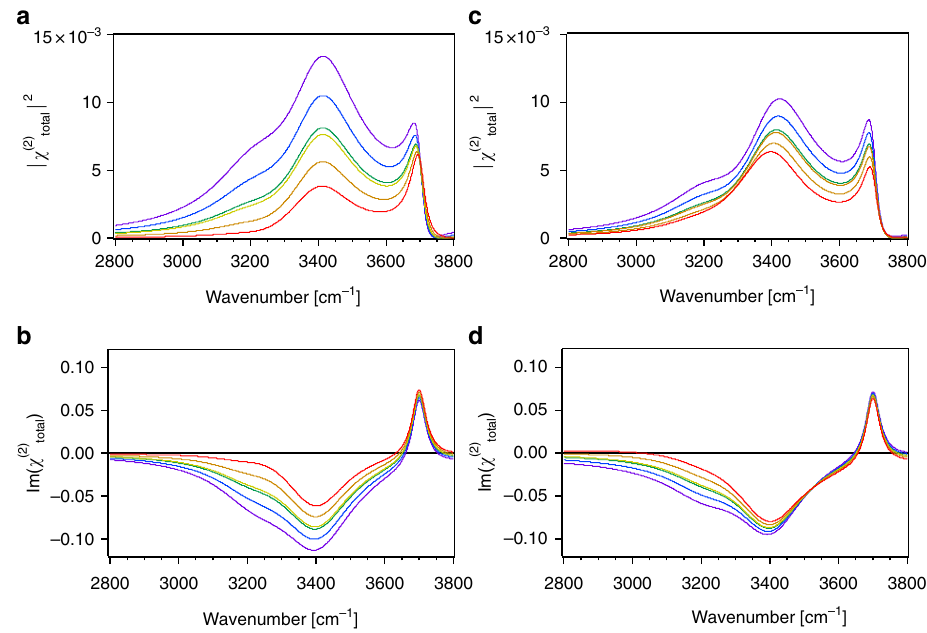
Fig. 5 Air/water interface. Intensity and imaginary SFG spectra for three oscillators on a surface simulated for ω 1 = 3200 cm − 1 , γ 1 = 0°, ω 2 = 3400 cm − 1 , γ = 0°, A M = 2, A M = 10, Γ = Γ = 120 cm − 1 , ω = 3700 cm − 1 , γ 2 1 1 2 2 1 2 3 and with c , d absorptive-dispersive interactions for charge densities of + 0.0003, + 0.00015, + 0.000015, − 0.0003, − 0.00015, and − 0.000015C/m 2 and ionic strength of 40 μ